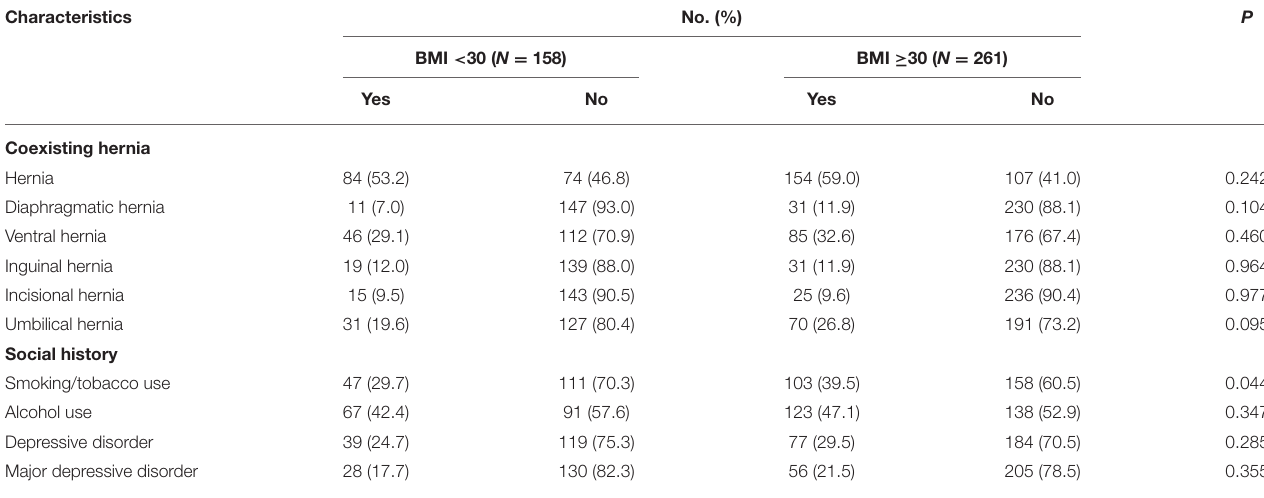
TABLE 2 | Characteristics of RAD men depending on BMI